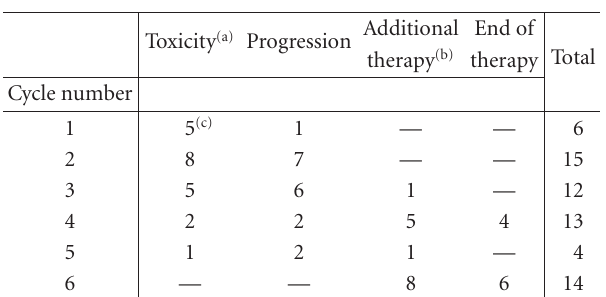
Table 3: Reasons to abandon the study during the first 6 cycles of